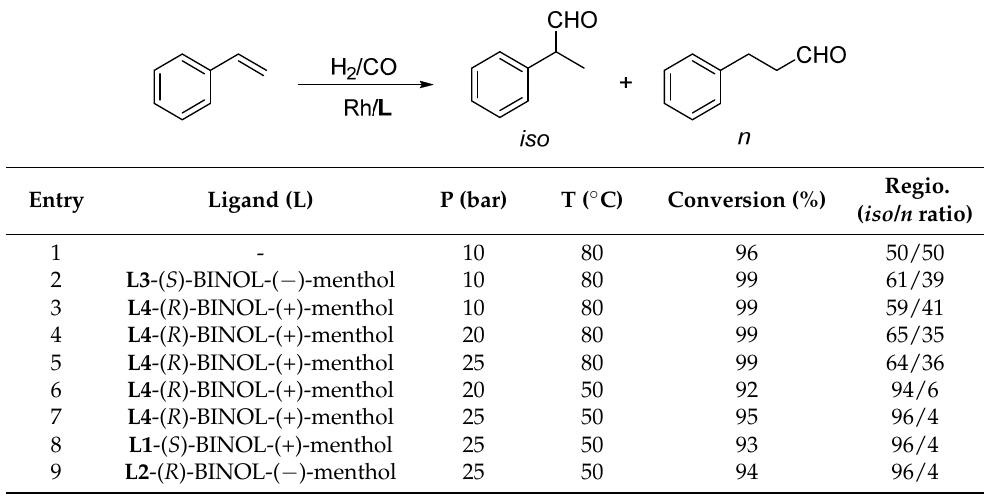
Table 1. Evaluation of monophosphite ligands L1 – L4 in Rh-catalysed hydroformylation of styrene a .